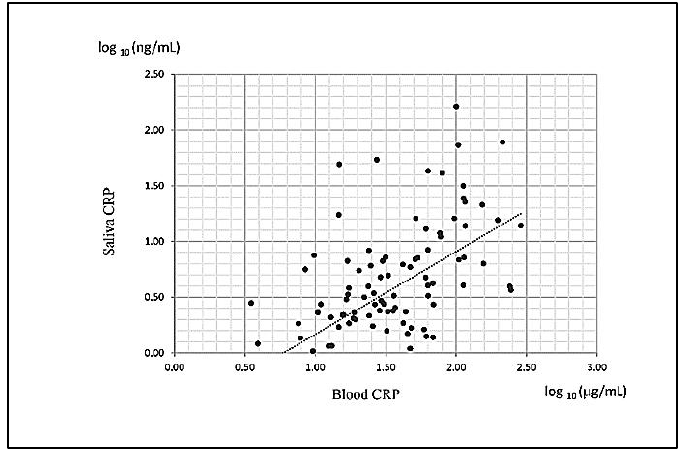
Figure 1. Scatter diagram of the serum and corresponding salivary CRP levels of children with pneumonia.